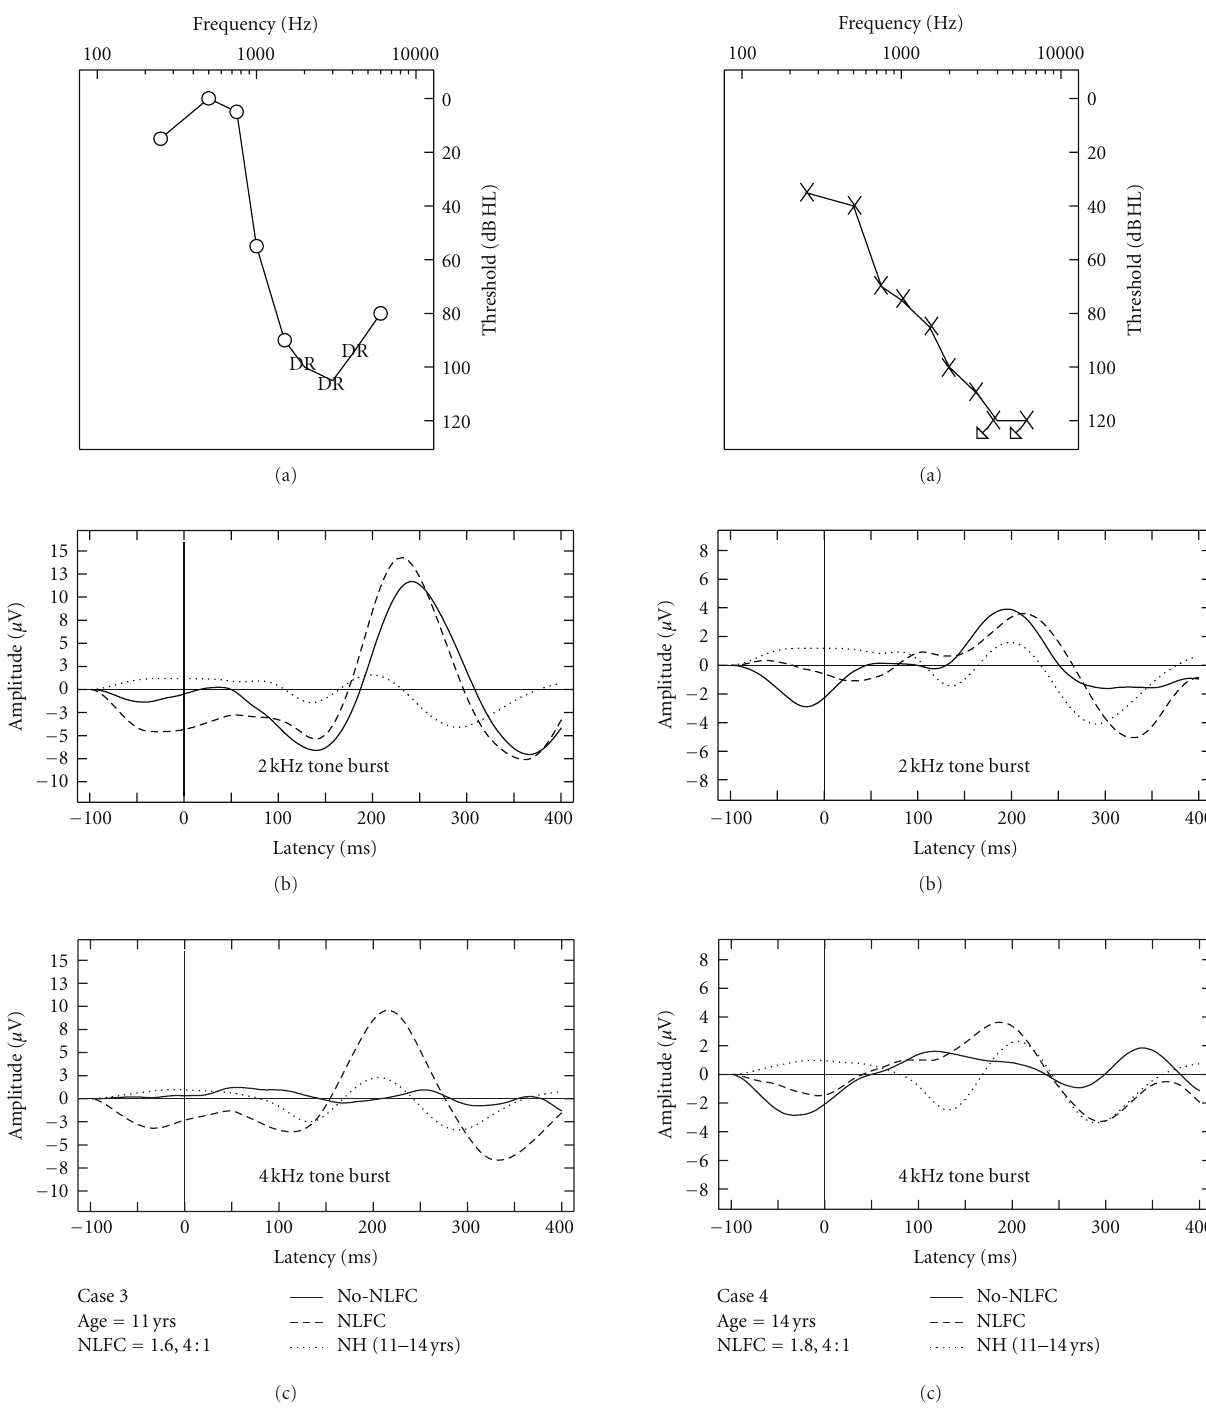
Figure 5: Case-specific grand mean CAEPs displayed across stimulus types and hearing aid conditions: no-NLFC (solid line), NLFC active (dashed line), and for each participant’s age-matched NH group (dotted line). Participant age and prescribed NLFC settings (cut-o ff frequency, compression ratio) are indicated in the legend. The top left corner pane displays test ear hearing thresholds, suspected cochlear dead regions (DR), and responses beyond the audiometric test range.